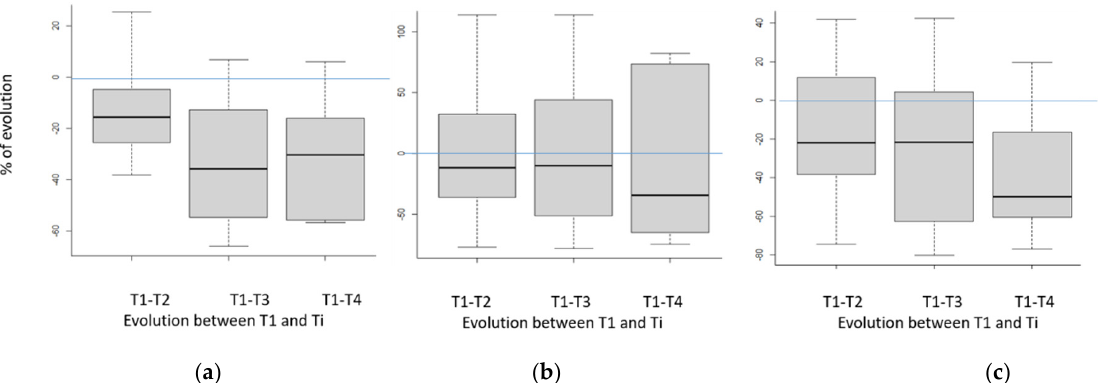
Figure 6. Kinetic of evolution for ( a ) shear force, ( b ) 20% compression shear, ( c ) 80% compressive shear) depending on ageing time for cooked meat expressed as a relative value of the content on day 7. T1, T2, T3 and T4 correspond to the different ageing times (respectively 7, 16, 35 and 60 days). Box-plot explanation: the central value represents the median; the edges of the rectangle are the quartiles and the extremities are calculated using 1.5 times the interquartile range.